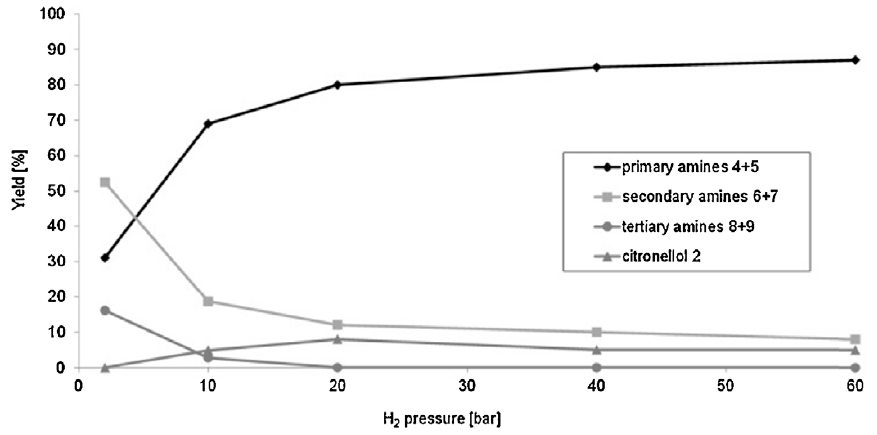
Figure 4. Reaction network in reductive amination of citronellal ( 1 ) with ammonia. Reprinted from [62] with permission from Elsevier.